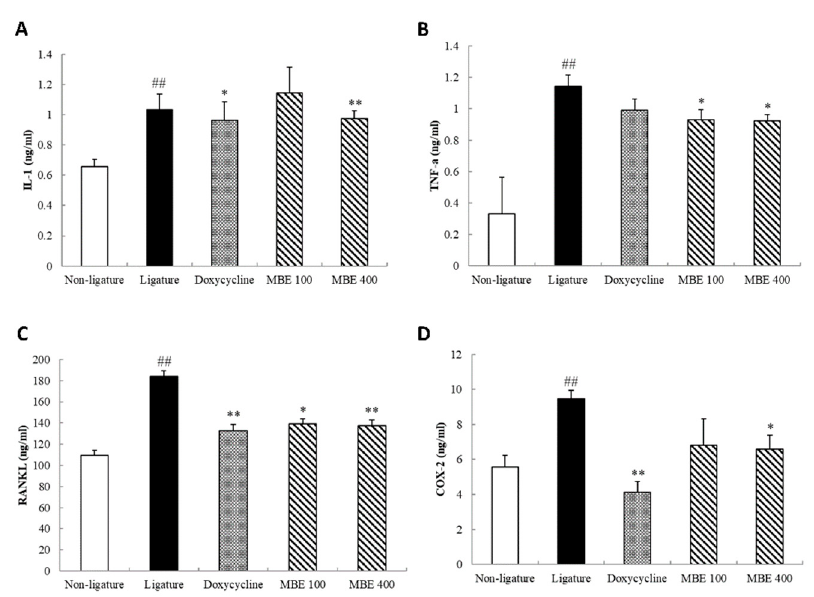
Figure 4. E ff ects of MBE on serum biochemistry in rats with ligature-induced periodontitis. The collected serum was analyzed for levels of ( A ) IL-1 β , ( B ) TNF- α , ( C ) COX-2, and ( D ) RANKL using commercial ELISA kits. The data are presented as mean ± SEM. * p < 0.05, ** p < 0.01, compared with ligature control group; ## p < 0.01, compared with nonligature control group ( n = 5 /